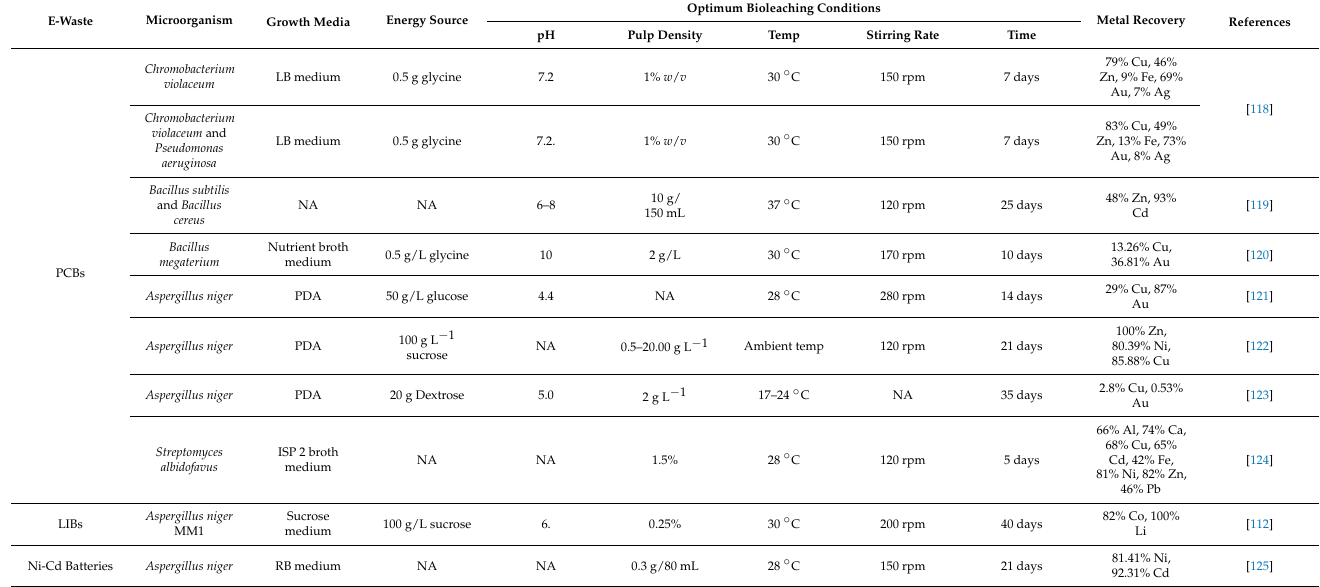
Table 4. A list of bioleaching studies on some selected e-wastes using heterotrophic microorganisms and their metal recovery aspects. (Note: Au, Ag, Li, In, etc., are included, wherever applicable, to reflect the overall study along with base metal